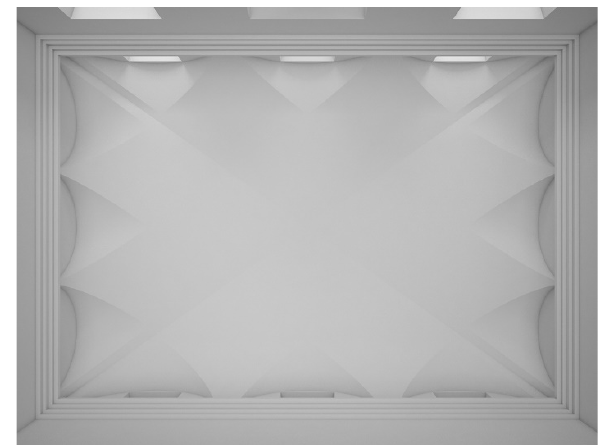
Figure 2. Reconstructive digital model of the lunette vault in the Castello di Govone (Modelling: F.